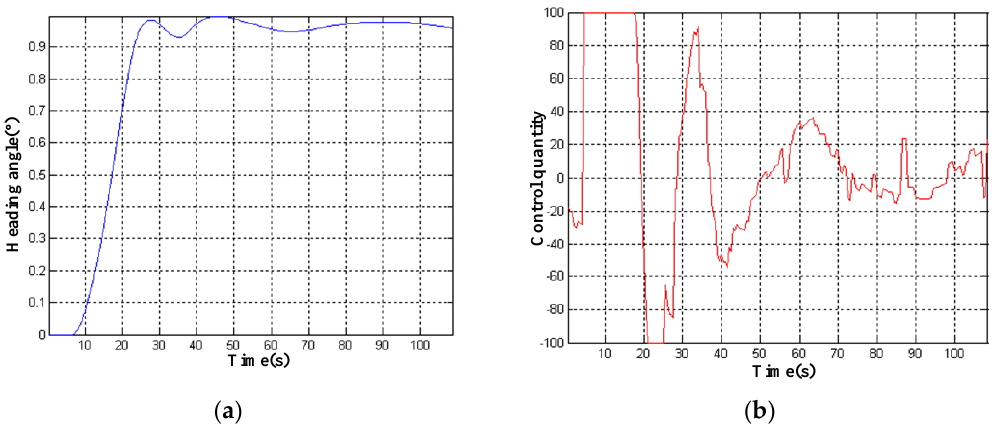
Figure 19. Step Response of traditional PID Controller . ( a ) heading; ( b ) controlled quantity.